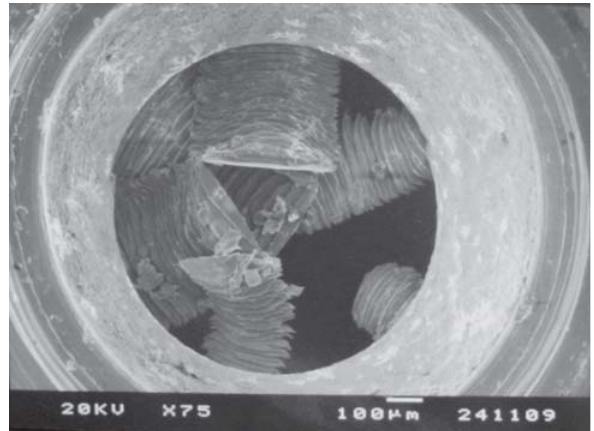
FIGURE 3- Fracture on the head of screw after mechanical cycling F(+)